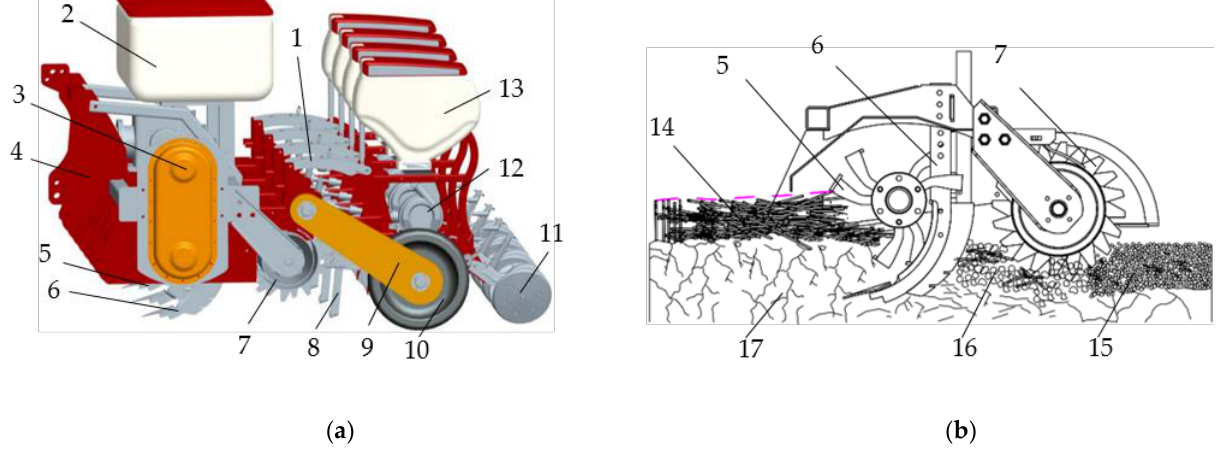
Figure 1. Structure and working principle of the WNPM seeder. ( a ) The overall structure of the WNPM seeder; ( b ) Method of seed bed preparation before sowing. Note: 1, Profiling mechanism; 2, Fertilizer box; 3, Side gearbox; 4, The frame; 5, Opposite-placed anti-blocking mechanism; 6, Subsoiling device; 7, Profiling and pressing device before sowing; 8, Ditching knife; 9, The support device of ground wheel; 10, The ground wheel; 11, Profiling and pressing device after sowing; 12, Air suction seed-metering device; 13, Seed box; 14, Farmland covered with straw; 15, Prepared seed bed before sowing; 16, Soil particle after subsoiling; 17, Hard soil before tillage.